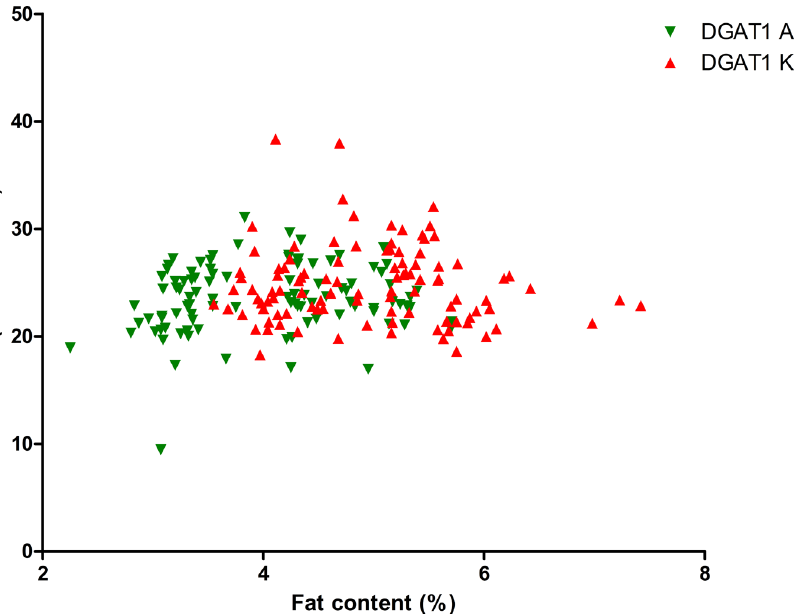
Figure 6. Relationship between fat content (%) and sphingomyelin (SM) content (% of total phospholipids (PL)) differentiated by DGAT1 genotype.